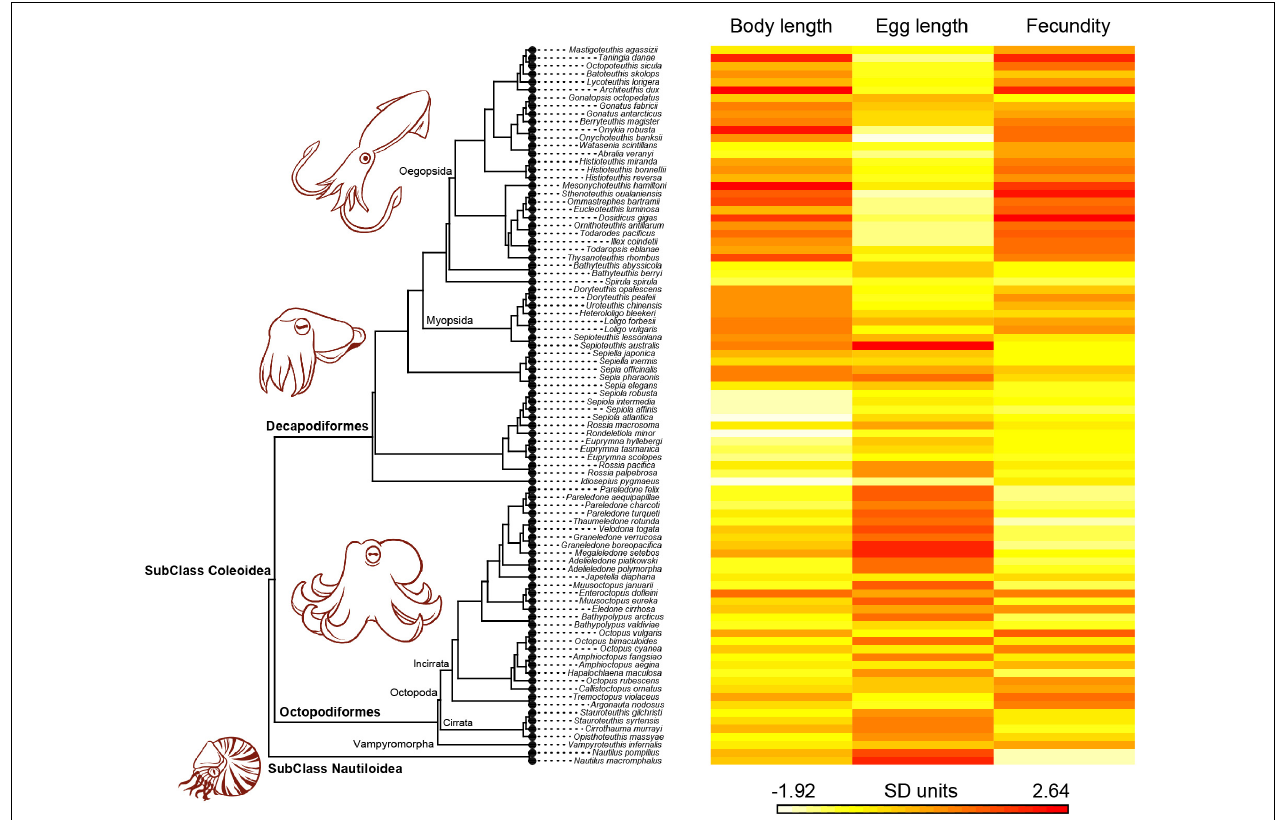
FIGURE 1 | Phylogenetic heatmap tree of cephalopods traits (body length, egg length, and potential fecundity) across the 90 studied species.